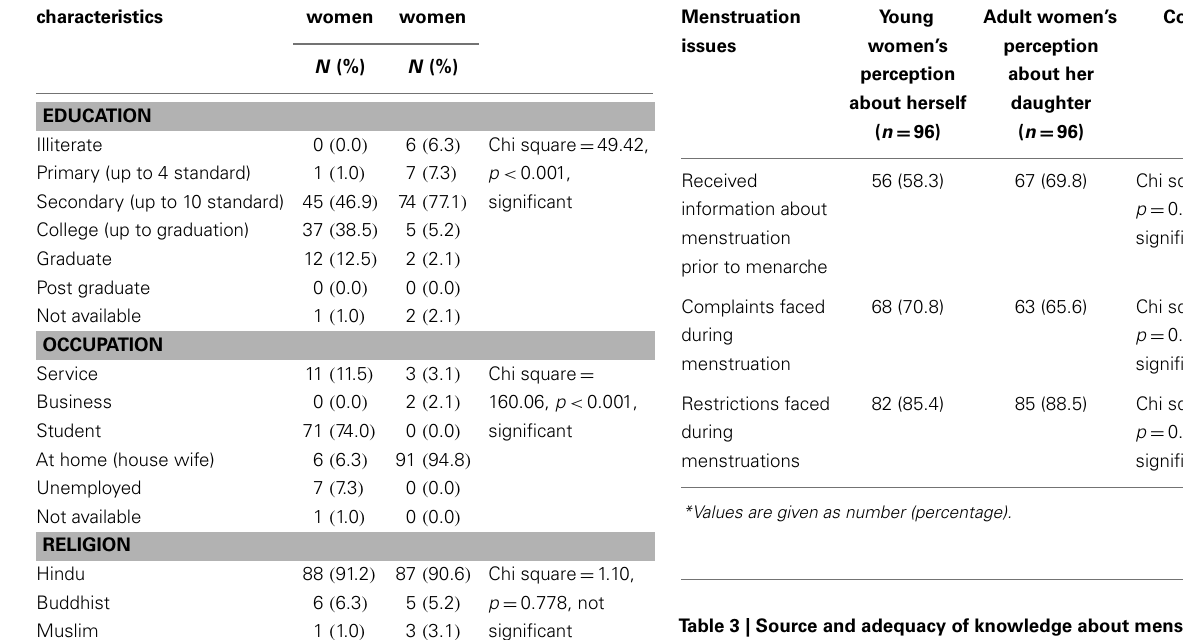
Table 3 | Source and adequacy of knowledge about menstruation among participants who had received some information before menarche*